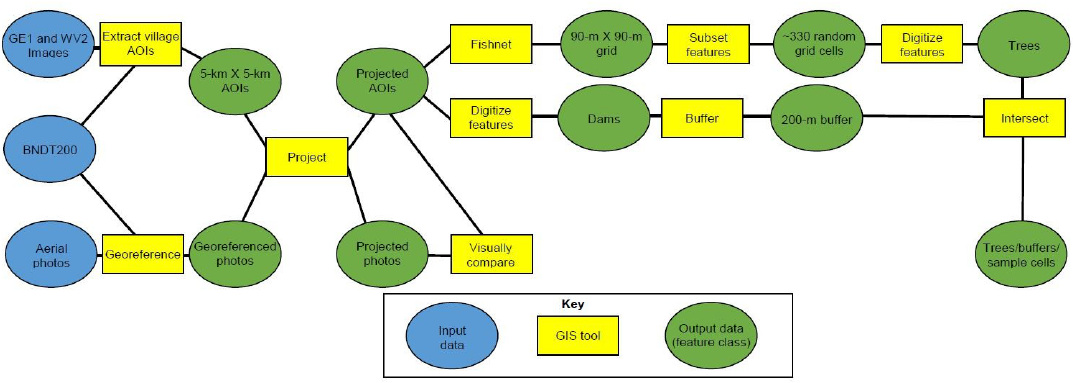
Figure 5. Flowchart of GIS Procedures.